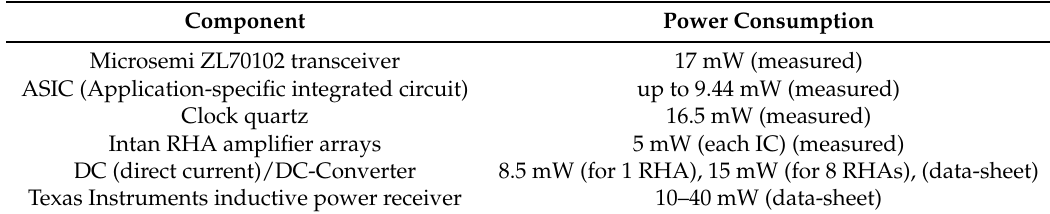
Table 2. Estimated power consumption of the implant’s components. Component Power